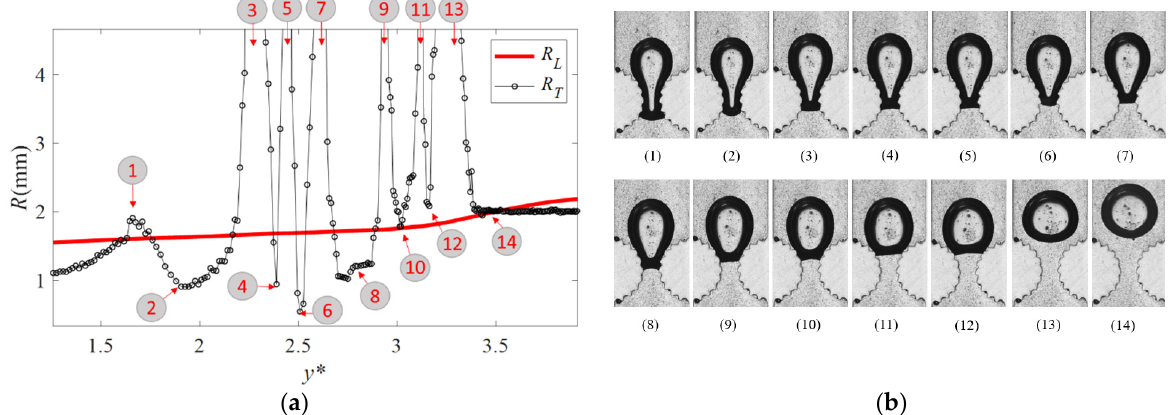
Figure 12. ( a ) zoomed-in condition represented in Figure 10a and ( b ) stages of bubble pinning in a pore.